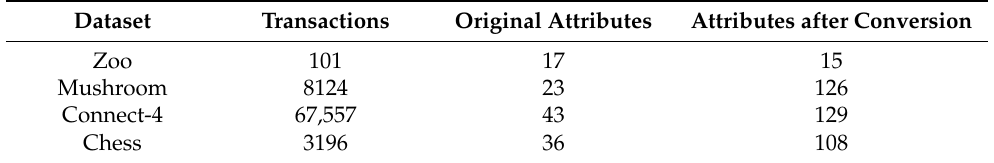
Table 9. Dataset